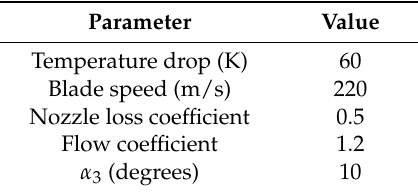
Table 2. Assumptions for preliminary